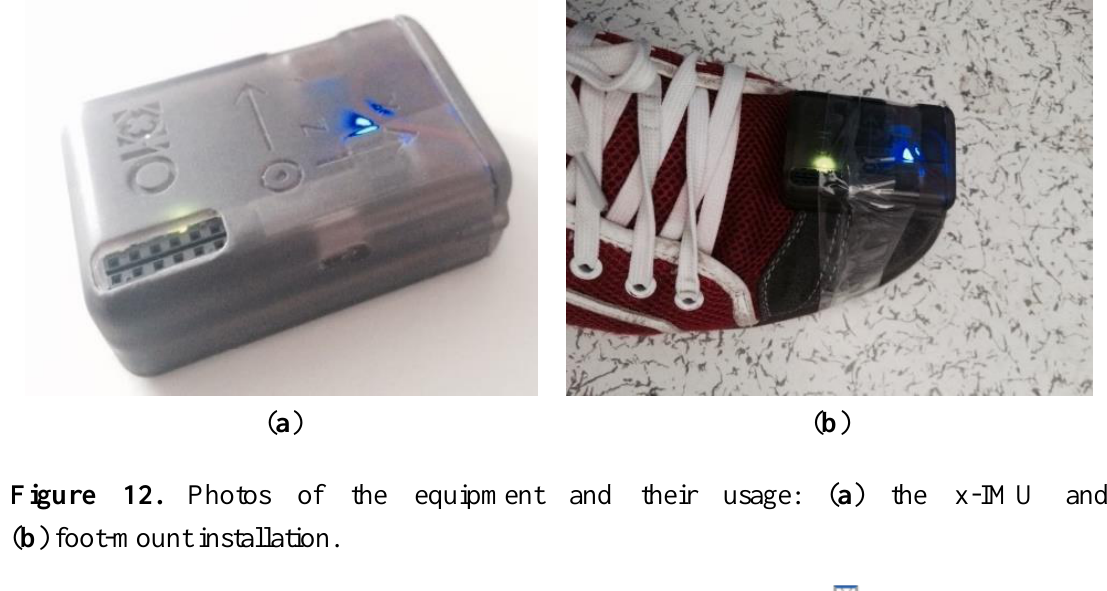
( a ) ( b ) Figure 12. Photos of the equipment and their usage: ( a ) the x-IMU and ( b ) foot-mount installation.